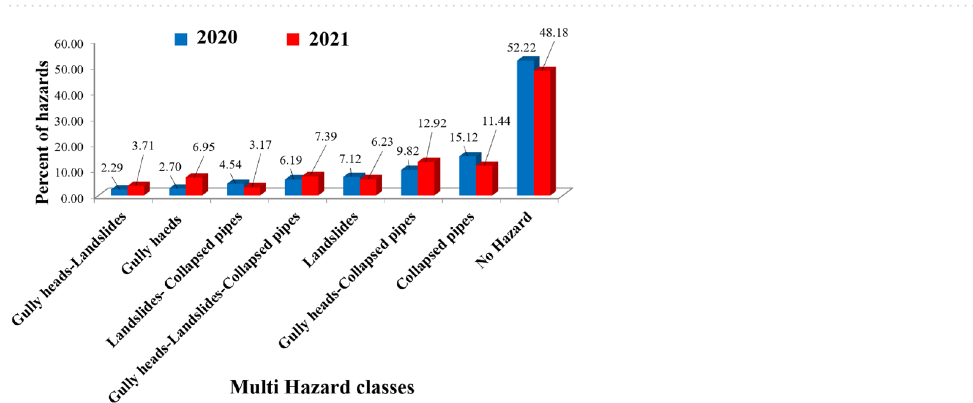
Figure 3. The susceptibility classes of multi-hazard prepared using ArcGIS 10.3.1 software (https://www.esri. com ) in 2020 and 2021.